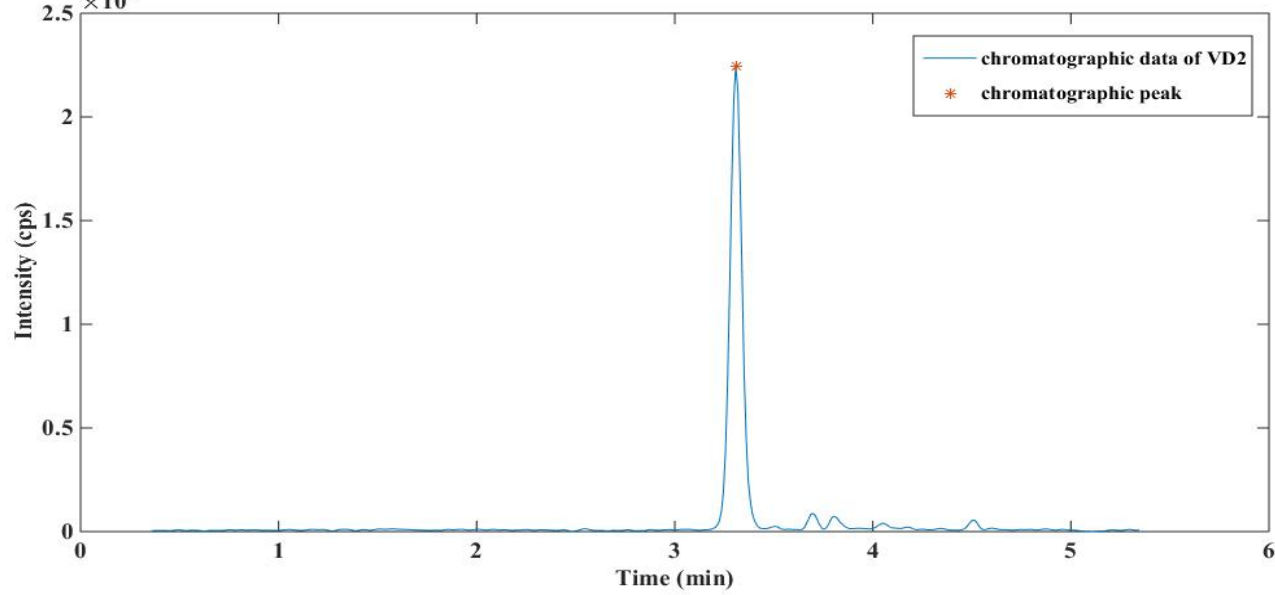
Figure 5. The extracted ion chromatogram of VD2 in an 80 ng/mL standard.